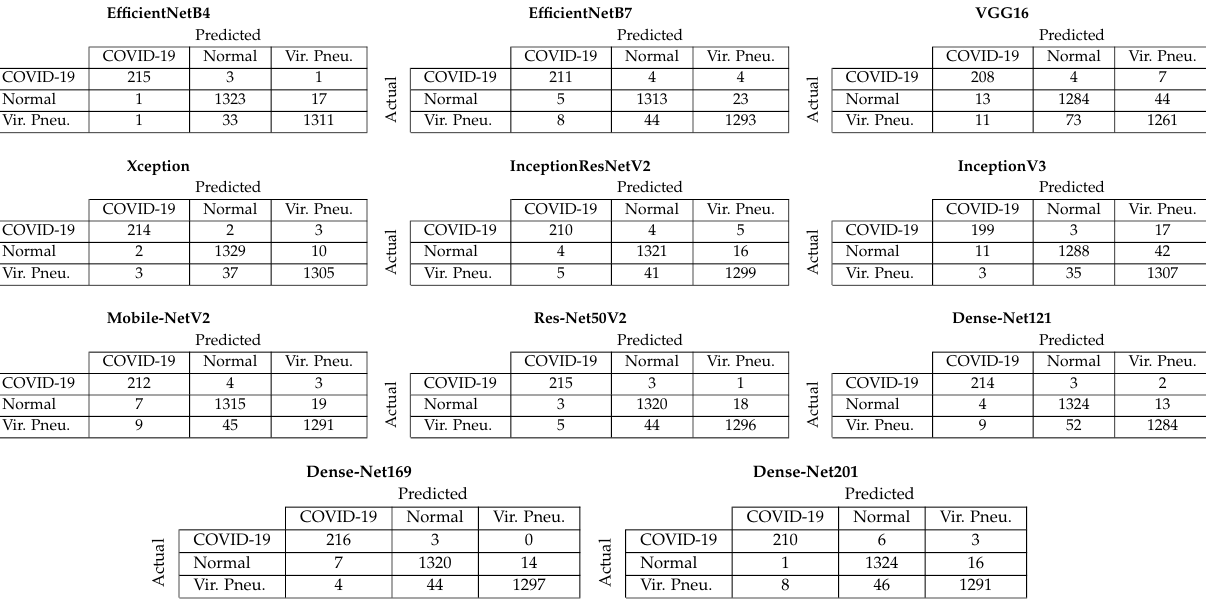
Figure 5. Grad-CAM visualisation for the COVID-19 class using the EfficientNetB4-based Ap- proach 1 model for four chest X-ray images. Table 6: Classification performance (%) of the best configurations versus other works using the same data set for the same task. Method